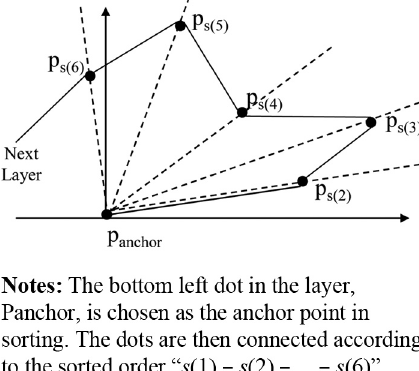
Figure 2. An illustration of sorting six dots in a layer by calling